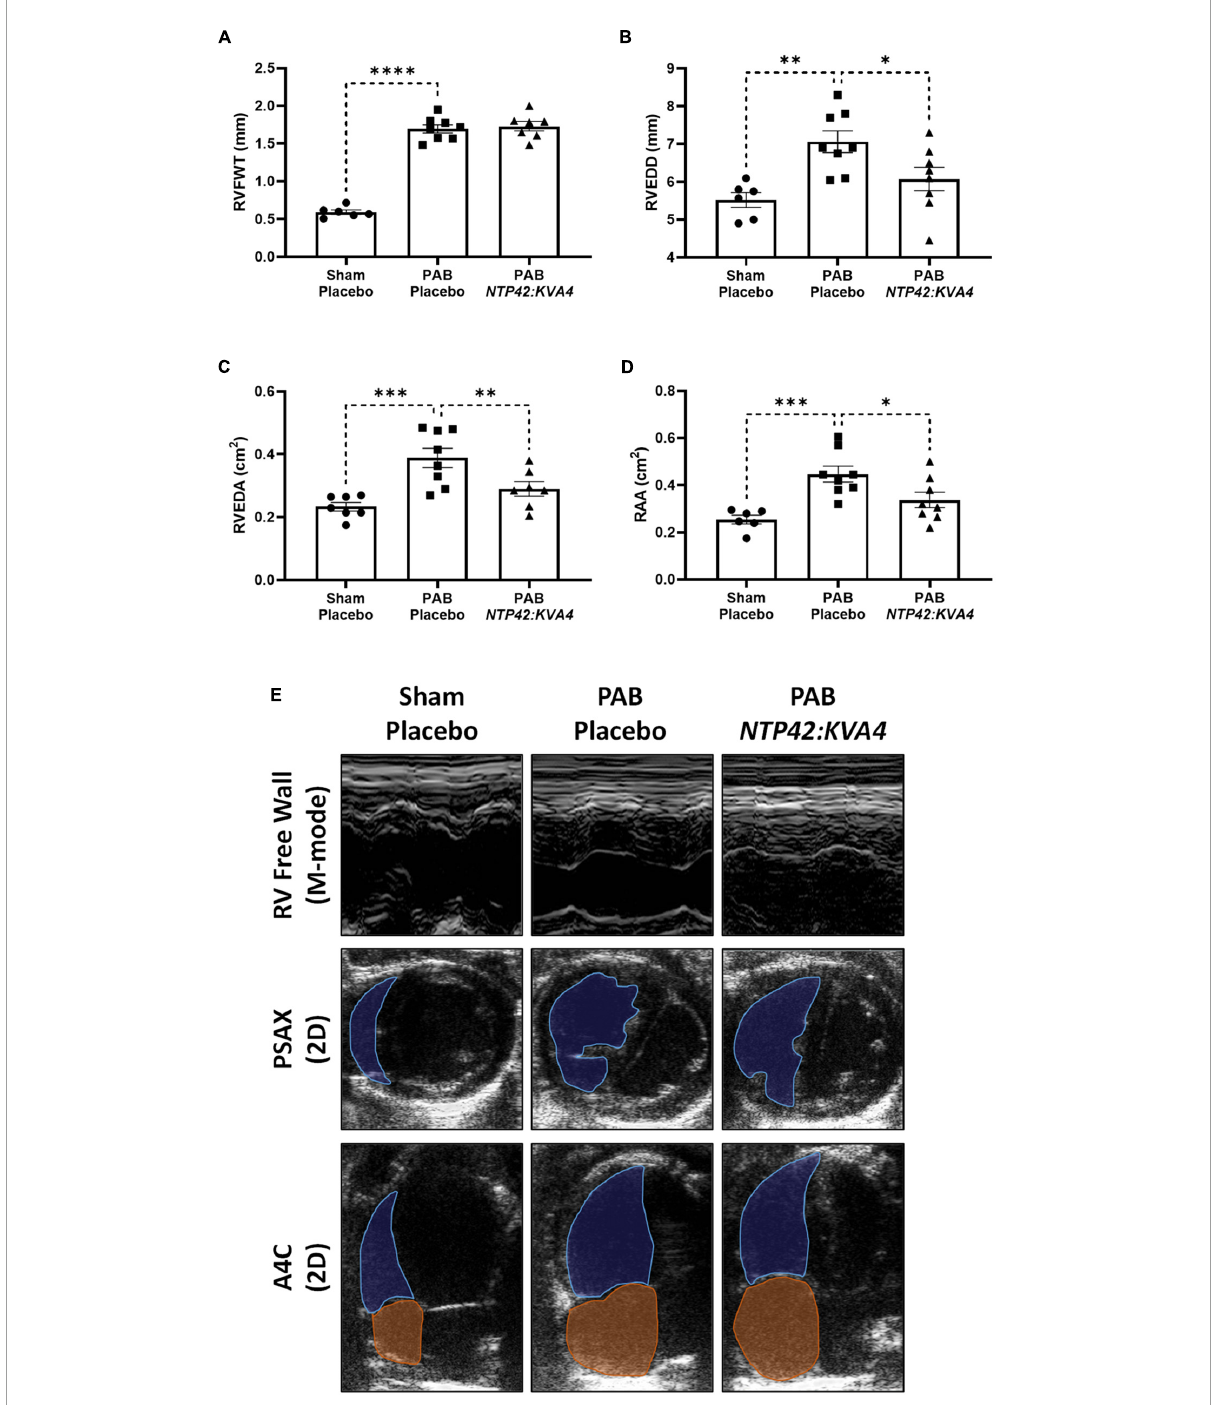
FIGURE2 Effect of NTP42:KVA4 treatment on right heart dimensions and geometry in the PAB model. Normal control rats (“Sham—Placebo”) and rats subjected to pulmonary arterial banding (PAB) were treated with either drug placebo (“PAB—Placebo”) or NTP42:KVA4 (1 mg/kg PO BID), starting from Day 2 following PAB. (A–D) Show ECHO-derived measurements of: (A) RVFWT in the “Sham—Placebo,” “PAB—Placebo,” and NTP42:KVA4 groups [ n = 6, 8, and 7, respectively]; (B) RVEDD [ n = 6, 8, 8]; (C) RVEDA [ n = 7, 8, 7], and (D) RA area (RAA) [ n = 6, 8, 7]. Data presented are the mean ± SEM. * P < 0.05, ** P < 0.01, *** P < 0.001, **** P < 0.0001 vs. “PAB—Placebo,” according to one-way ANOVA with Holm-Šídák correction. (E) Shows representative ECHO images from M-mode recordings and from 2D parasternal short-axis (PSAX) and apical four-chamber (A4C) views selected from a random animal from each treatment group and where blue and orange shading and lines delineate the RV and RA,